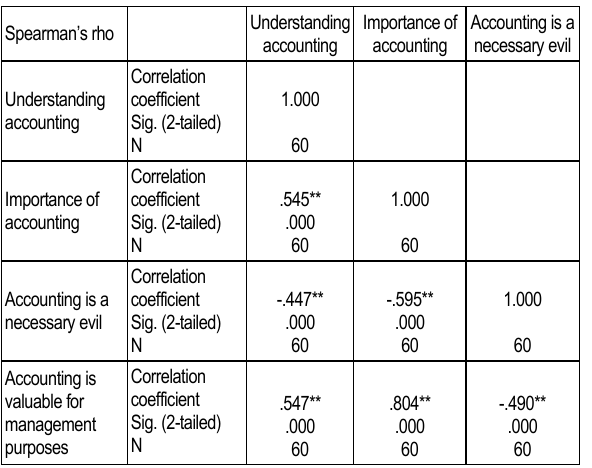
Table 2. Spearman’s rho